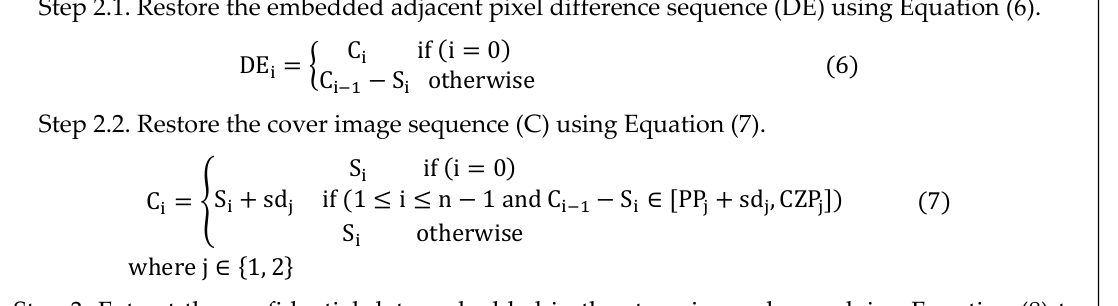
Figure 3. Data extraction and original cover image restoration procedure of APD.